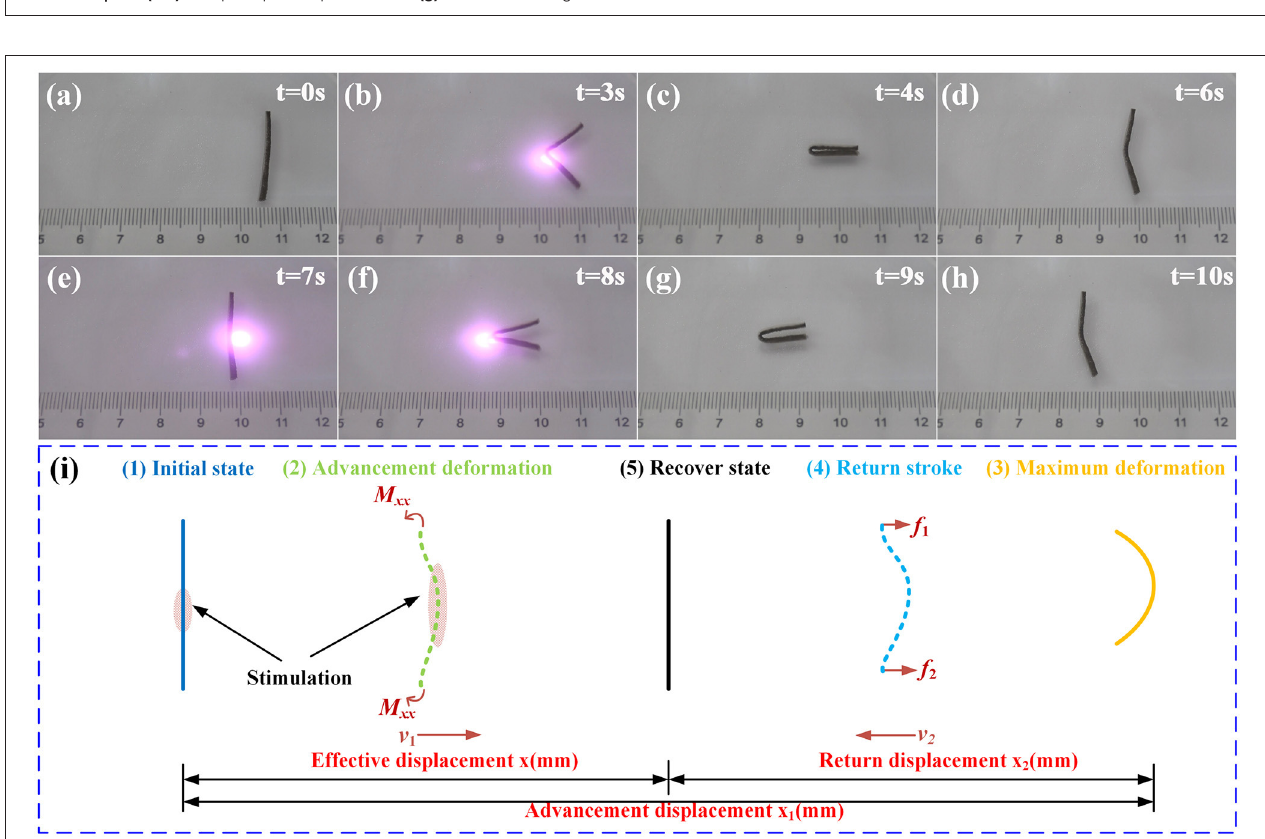
FIGURE 9 | The (a–h) multiple repetitive process and (i) a schematic diagram of forward